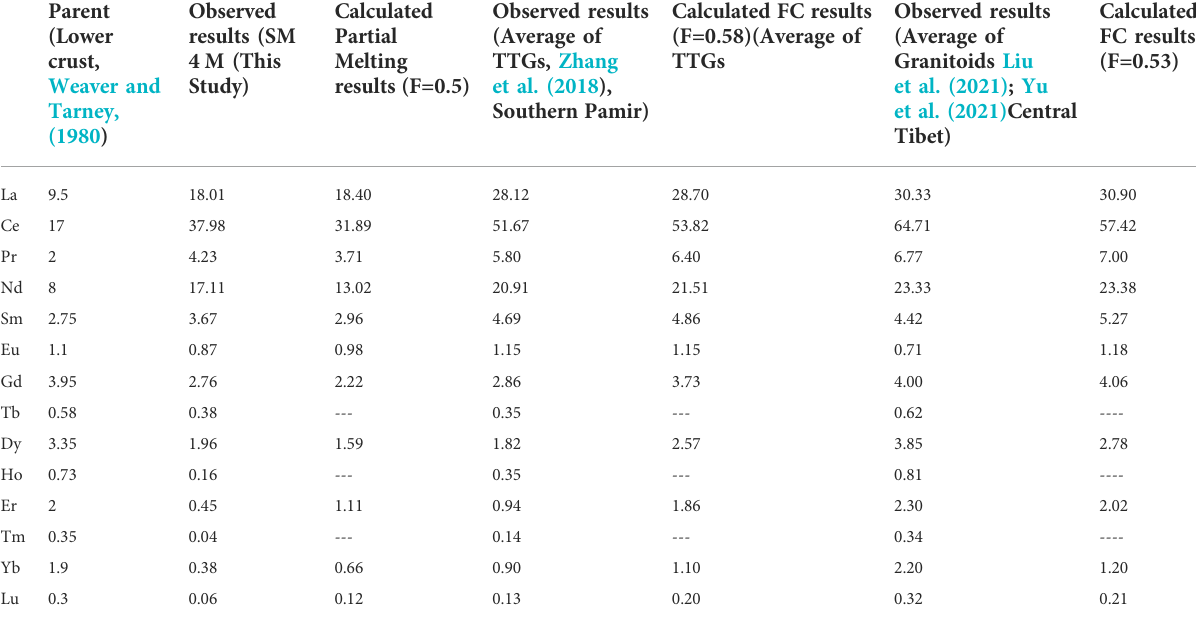
TABLE 3 Trace and rare Earth elements (REEs) modeling results for the studied tonalite gneiss (SM4 M), TTGs of the South Pamir terrane, and Central Tibet.